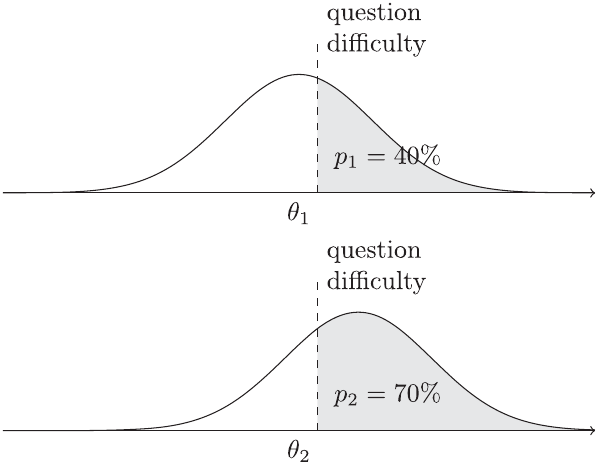
FIG. 2. Distributions of students ’ proficiencies. Top, before the intervention; bottom, after the intervention. The vertical dashed line is the question difficulty. Proportions of correct answers correspond to gray areas.